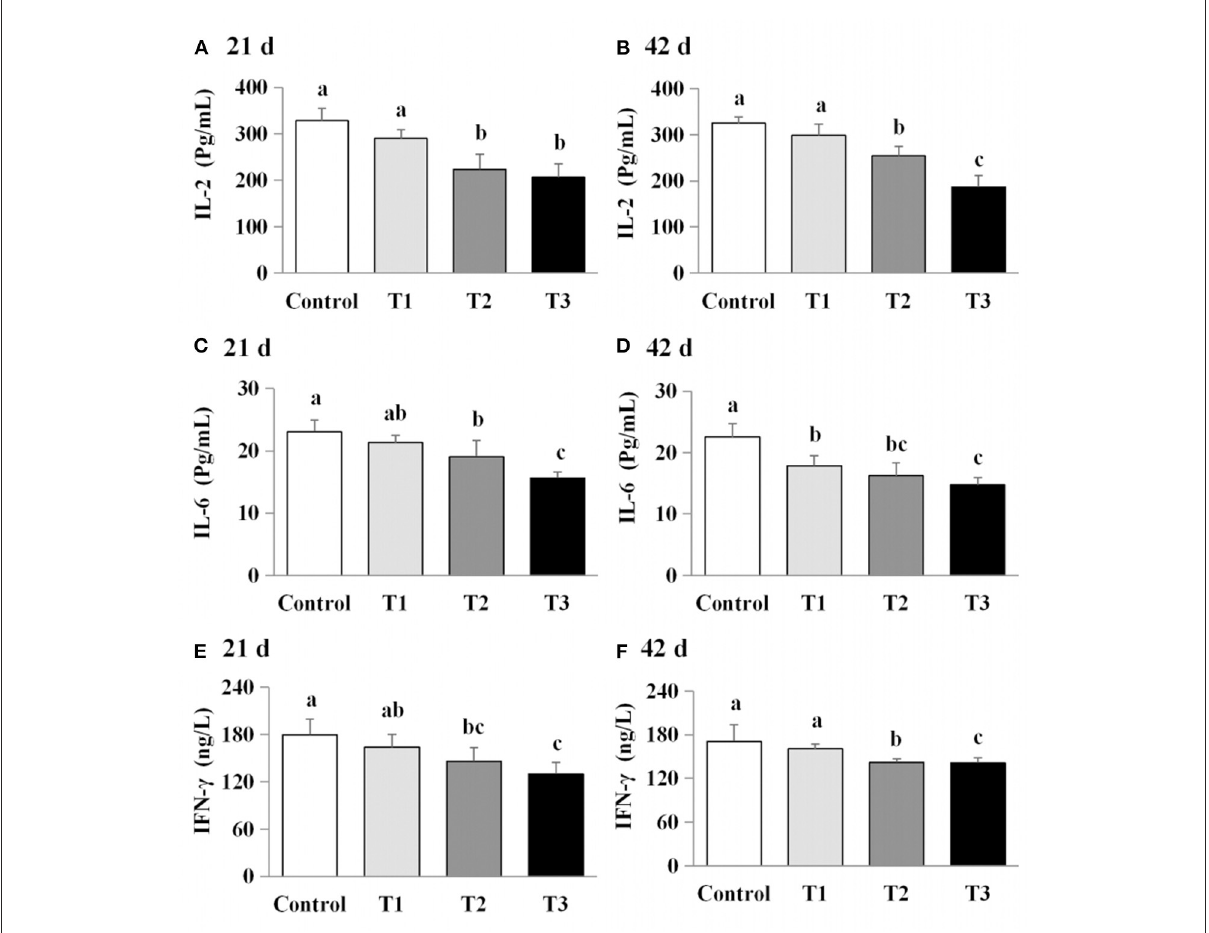
FIGURE5 Effects of AFB1 on the immune factors content in serum of chicks on day 21 and day 42. (A) IL-2 content on day 21. (B) IL-2 content on day 42. (C) IL-6 content on day 21. (D) IL-6 content on day 42. (E) IFN- γ content on day 21. (F) IFN- γ content on day 42. Control: control group. T1: low doses of AFB 1 group. T2: medium doses of AFB 1 group. T3: high doses of AFB 1 group. Data represent the means ± SD values of six replicate cages and were compared using one-way analysis of variance (ANOVA) followed by Duncan’s multiple comparison tests. Different letters on the same row indicate significant differences ( P <